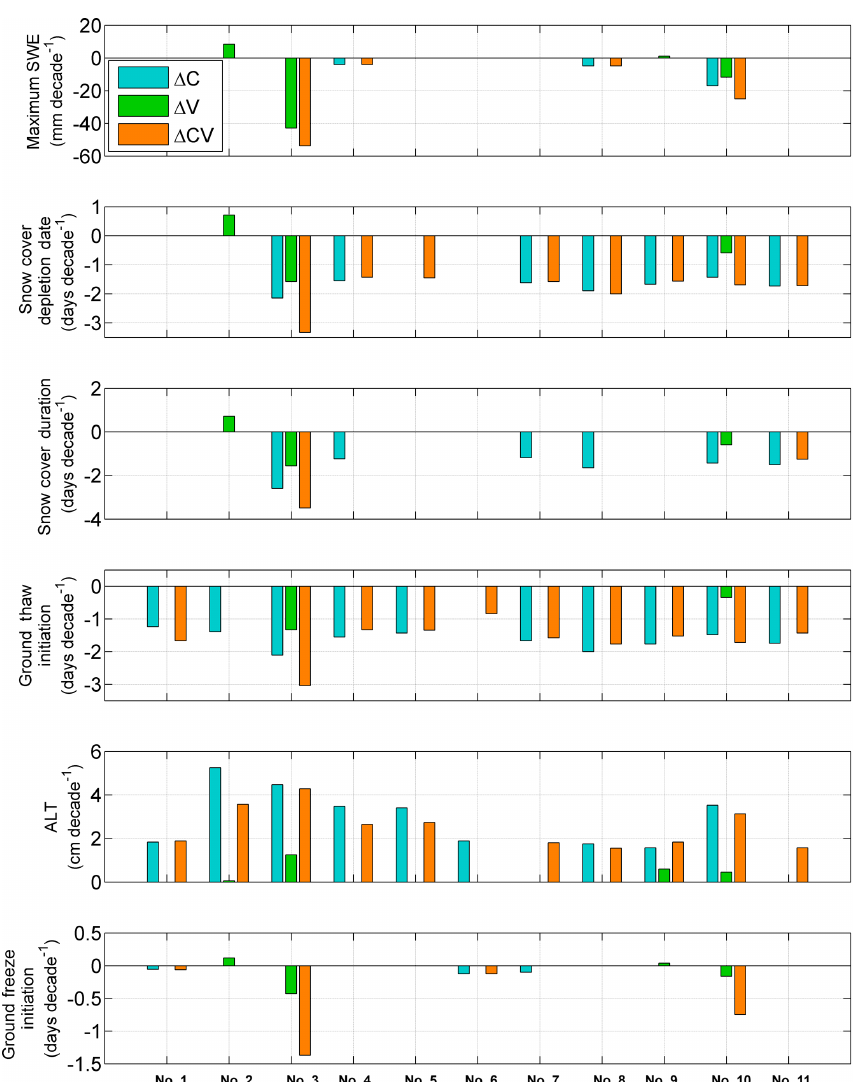
Figure 7. Comparison of significant trends ( p ≤ 0 . 05) for snow and ground freeze/thaw-related variables at HRU scale for the three scenarios. Note that trends for snow cover depletion date, snow cover duration and ground thaw initiation are in dates, and for maximum SWE, ALT and snow ablation are shown in rates. The x axis is as follows: upper tundra (no. 1), upper sparse shrubs (no. 2), upper gully/drift (no. 3), close shrubs (no. 4), taiga forest (no. 5), forest (no. 6), lower tundra (no. 7), open water (no. 8), lower sparse shrubs (no. 9), lower gully/drift (no. 10) and wetland (no. 11). ALT: active layer thickness. SWE: snow water